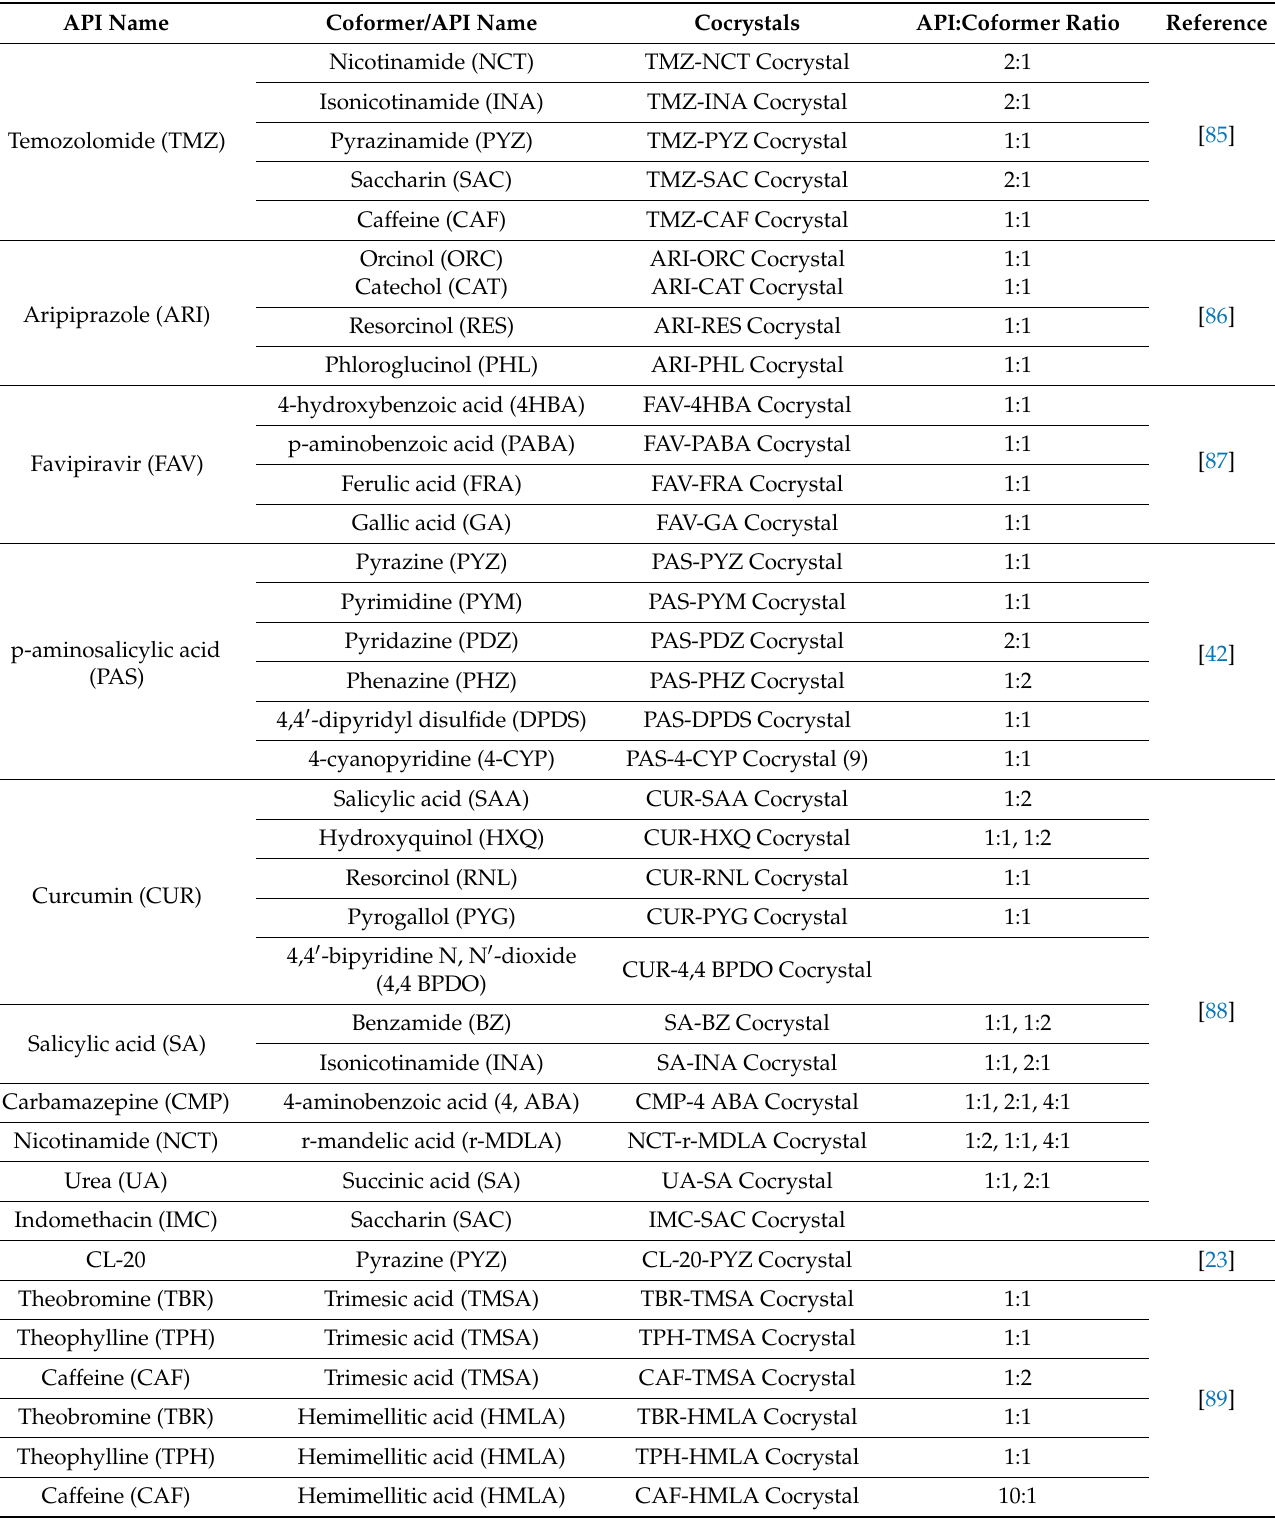
Table 5. Reported coformers in literature used in the formation of